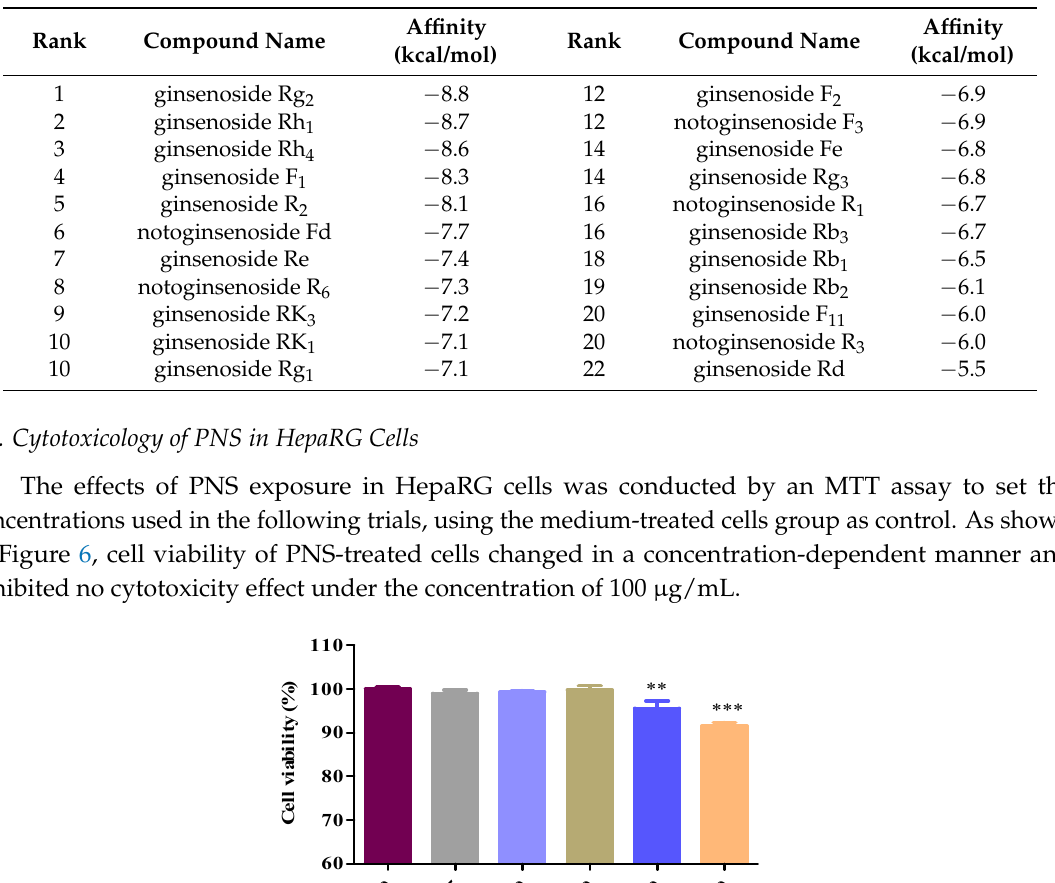
Figure 7. Hydrolysis of aspirin (ASA) in HepaRG cell homogenates treated with PNS. HepaRG cells homogenates were prepared and then diluted with 50 mM HEPES buffer (pH 7.4). Hydrolysis of ASA (1.8 µg/mL) in cell homogenates was conducted in the presence/absence of PNS. No significance (ns) was detected between BNPP (68 µg/mL) and PNS (150 µg/mL) treated group. Data were presented as mean ± SD ( n = 3). *, and ** denoted results significantly different compared with the control group ( p < 0.05, p < 0.01, respectively).